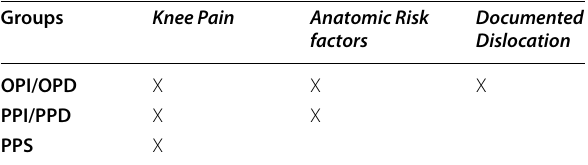
Table 1 Classification according to H. Dejour et al.